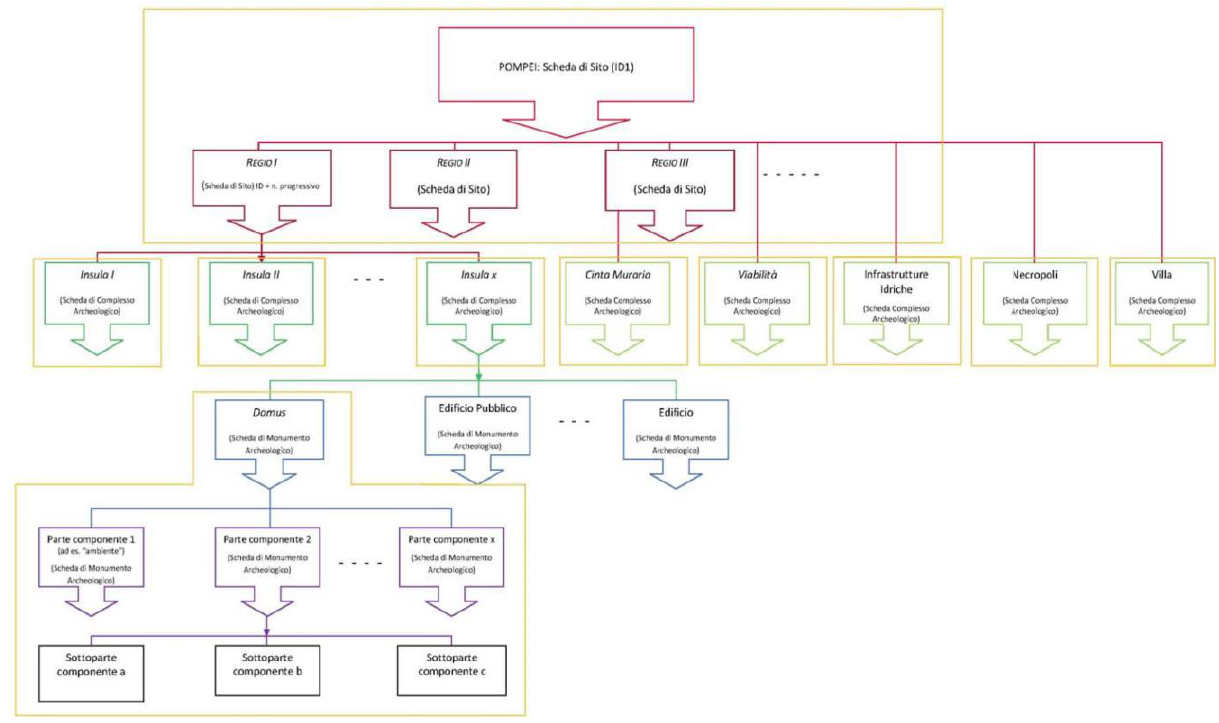
Figure 1. Logical scheme of the GPP Information System (Technical annex